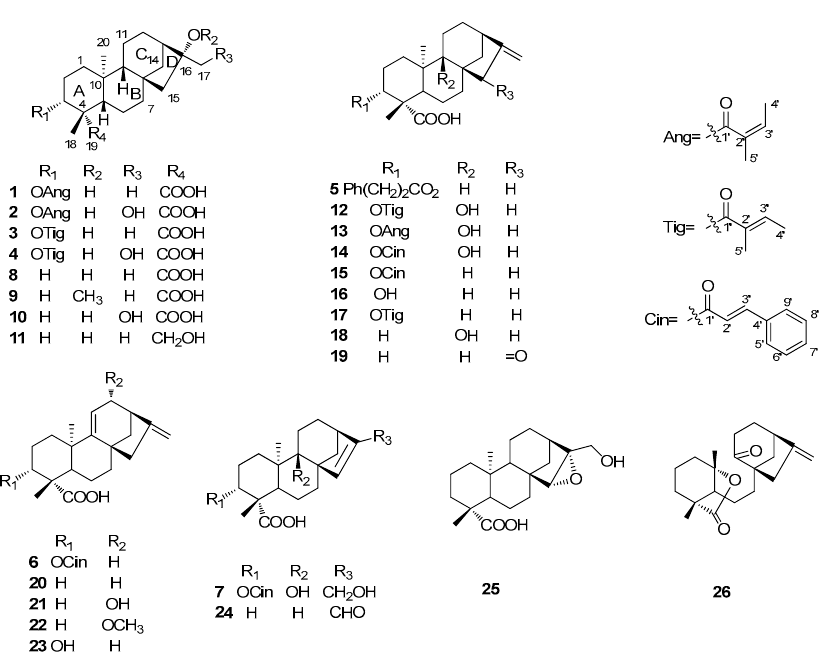
Figure 1. Chemical structures of 1 – 26 from Wedelia trilobata .